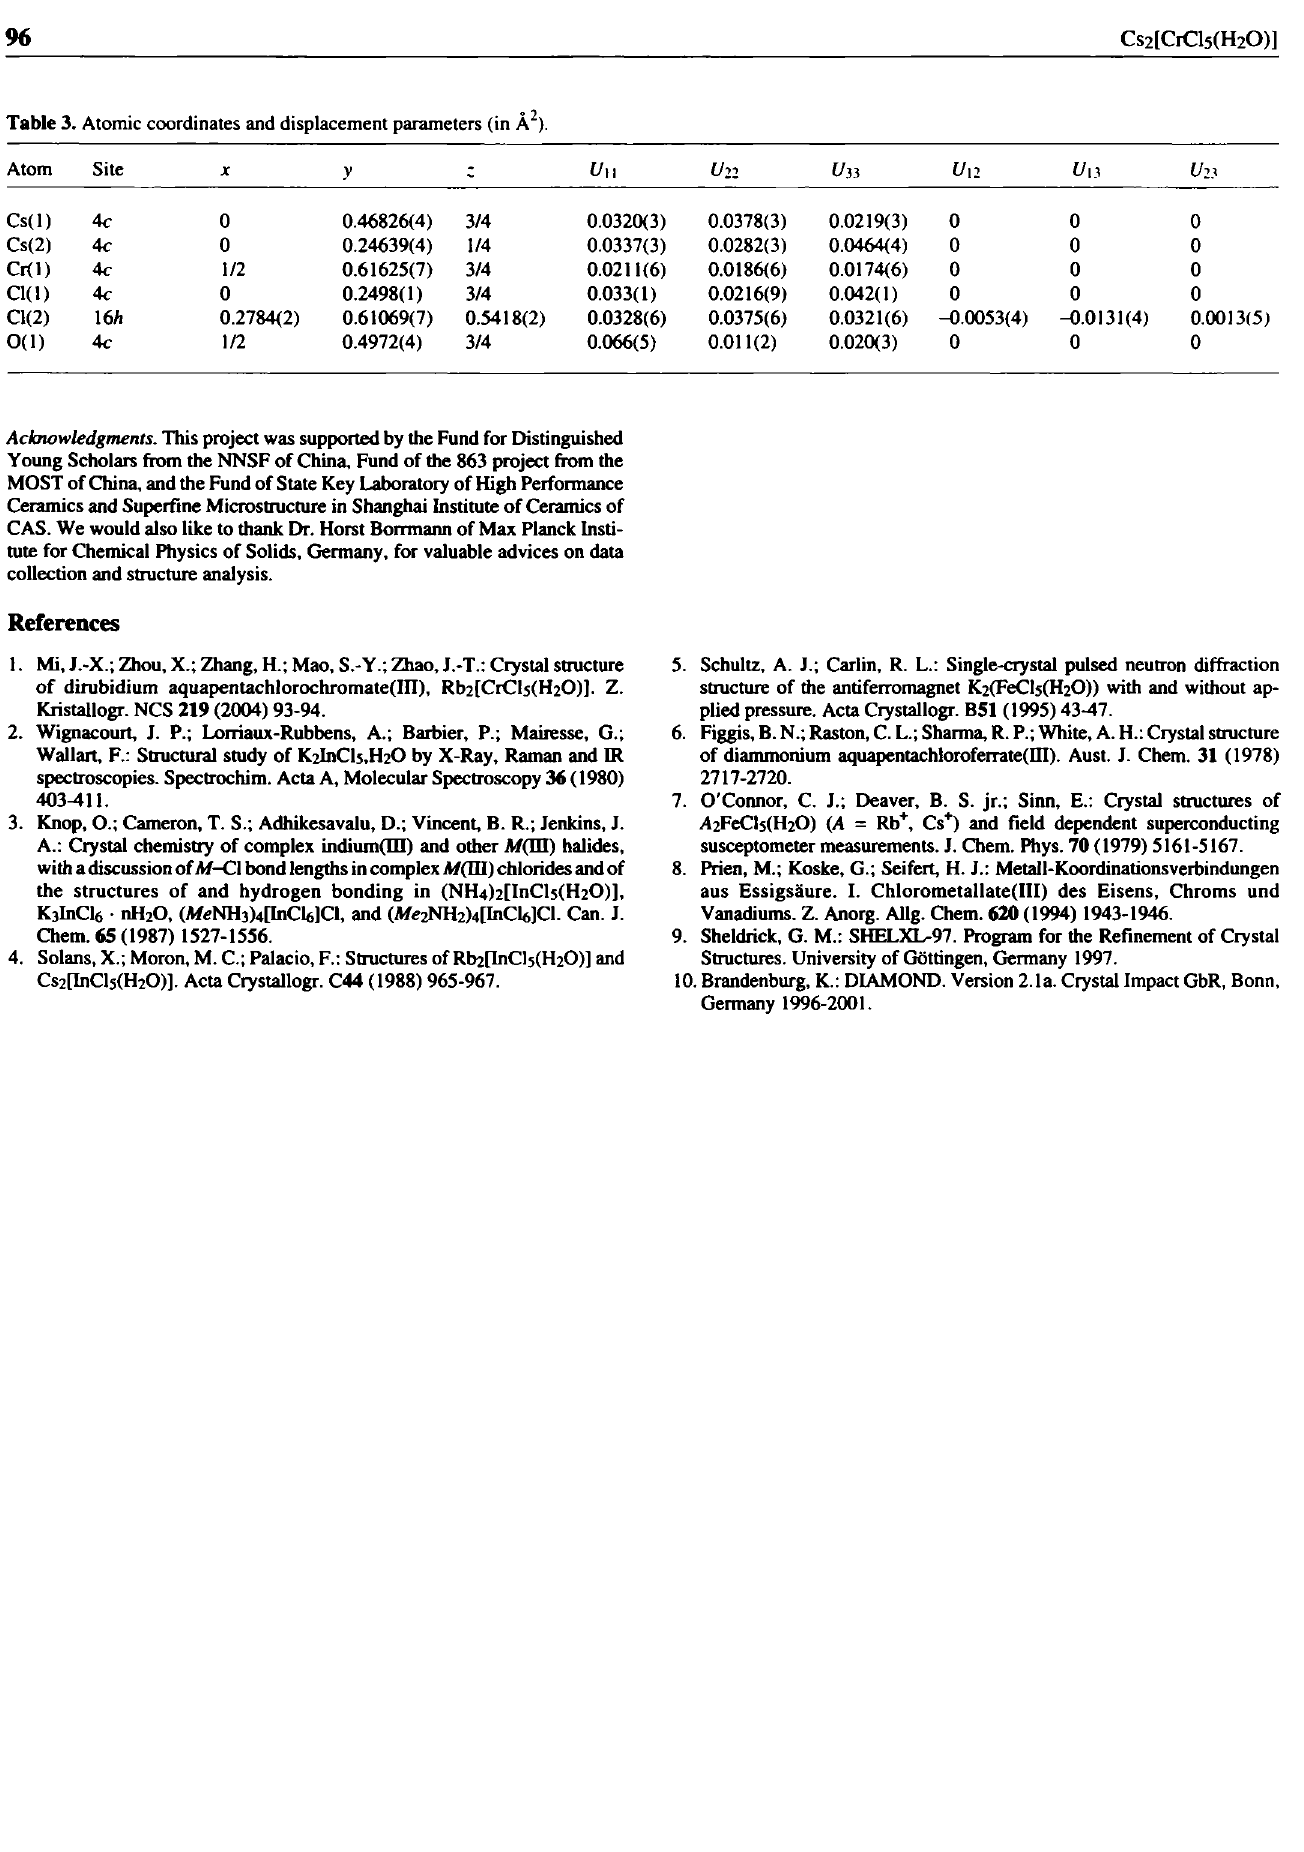
Table 3. Atomic coordinates and displacement parameters (in Â 2